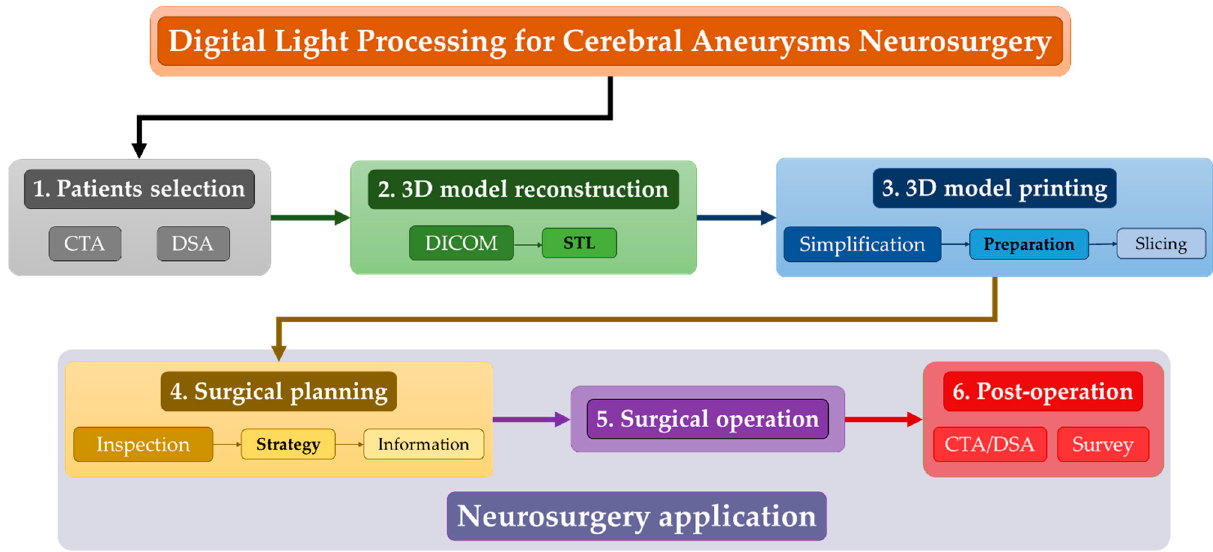
Figure 1. Flowchart of the activities carried out for the reproduction of the cerebral aneurysms through the digital light processing 3D printing technique and their subsequent use for the surgical planning and operation. CTA: computer tomography angiography; DSA: digital subtraction angiography; DICOM: Digital Imaging and Communication in Medicine; STL: Standard Triangulation Language.